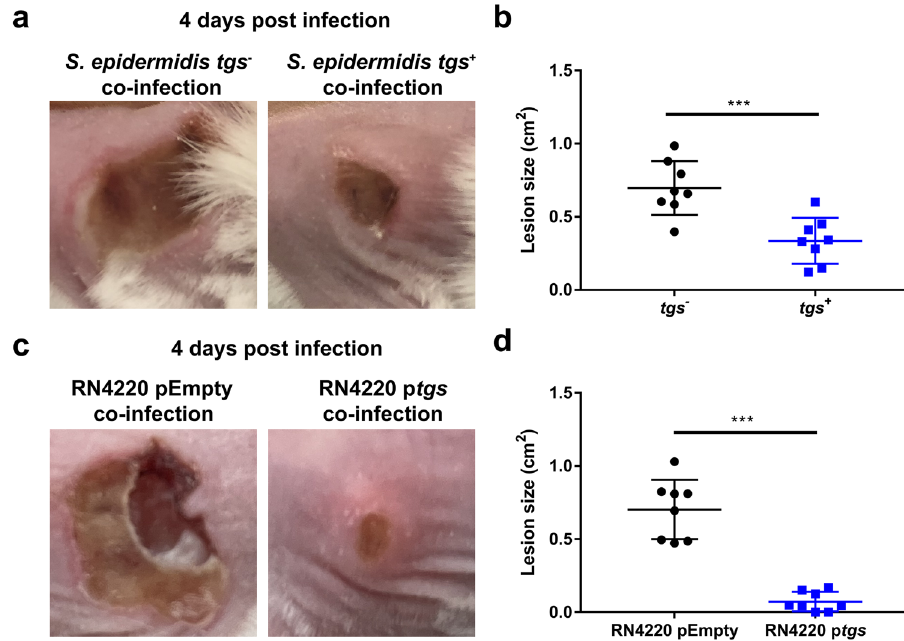
Fig. 4 tgs expressing staphylococci reduce skin damage caused by S. aureus during co-infection. a Representative images showing necrotic skin lesions 4 days post infection with S. aureus + tgs- negative S. epidermidis str. VCU036 or S. aureus + tgs -positive S. epidermidis str. M23864:W2 in a 1:1 ratio. b Quantitation of necrotic skin lesion size 4 days post infection with S. aureus + tgs -negative S. epidermidis str. VCU036 or S. aureus + tgs -positive S. epidermidis str. M23864:W2 in a 1:1 ratio. Results are from one representative experiment enumerating 8 lesions per group ( n = 4 animals per group). Data are shown as mean ± SD (*** p ≤ 0.001. Two-sided unpaired t -test). c Representative images showing necrotic skin lesions 4 days post infection with S. aureus + RN4220 pEmpty or S. aureus + RN4220 p tgs in a 1:1 ratio. d Quantitation of necrotic skin lesion size 4 days post infection with S. aureus + RN4220 pEmpty or S. aureus + RN4220 p tgs in a 1:1 ratio. Results are from one experiment enumerating 8 lesions per group ( n = 4 animals per group). Data are shown as mean ± SD (*** p ≤ 0.001. Two-sided unpaired t